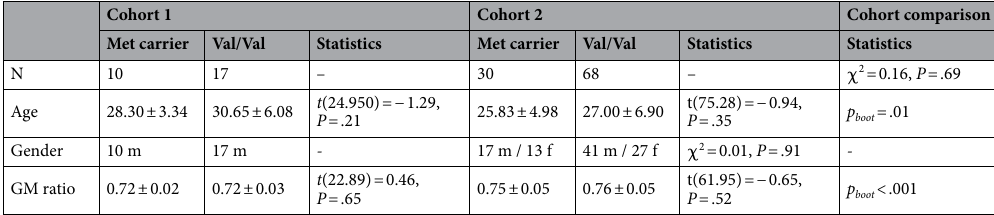
Table 1. Demographic characteristics of BDNF Val66Met Met carriers and Val homozygotes. GM ratio: ratio of gray matter volume in the pgACC voxel. Between-cohort comparisons of age and GM ratio with bootstrapped one-sample t-tests (20,000